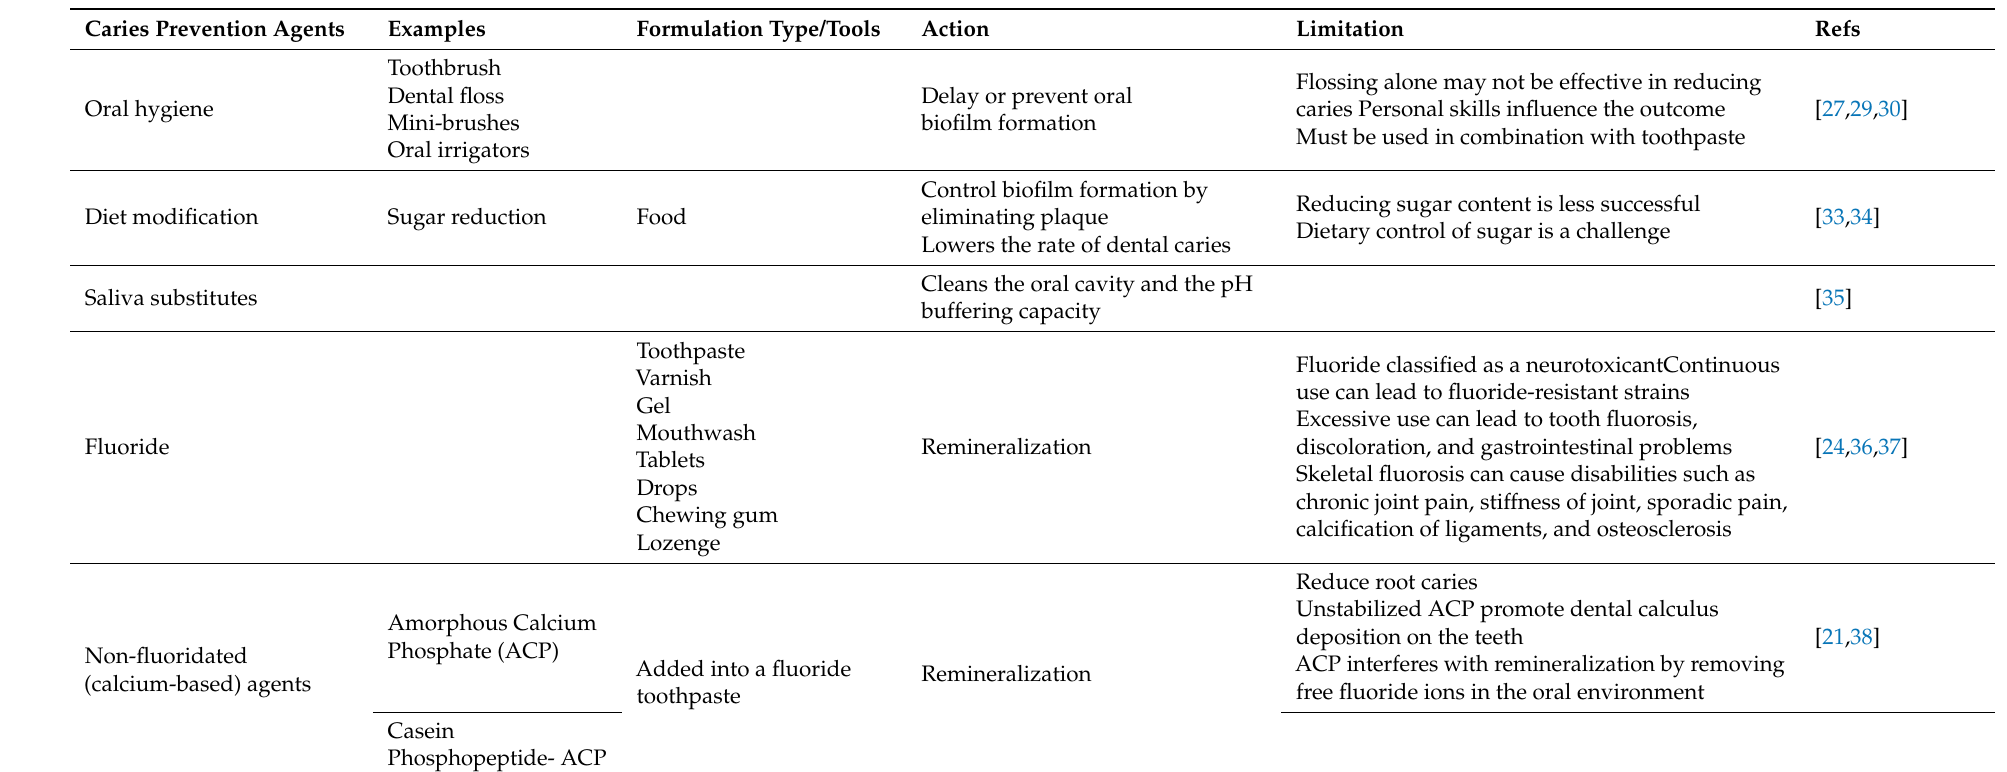
Table 1. Preventive strategies for dental